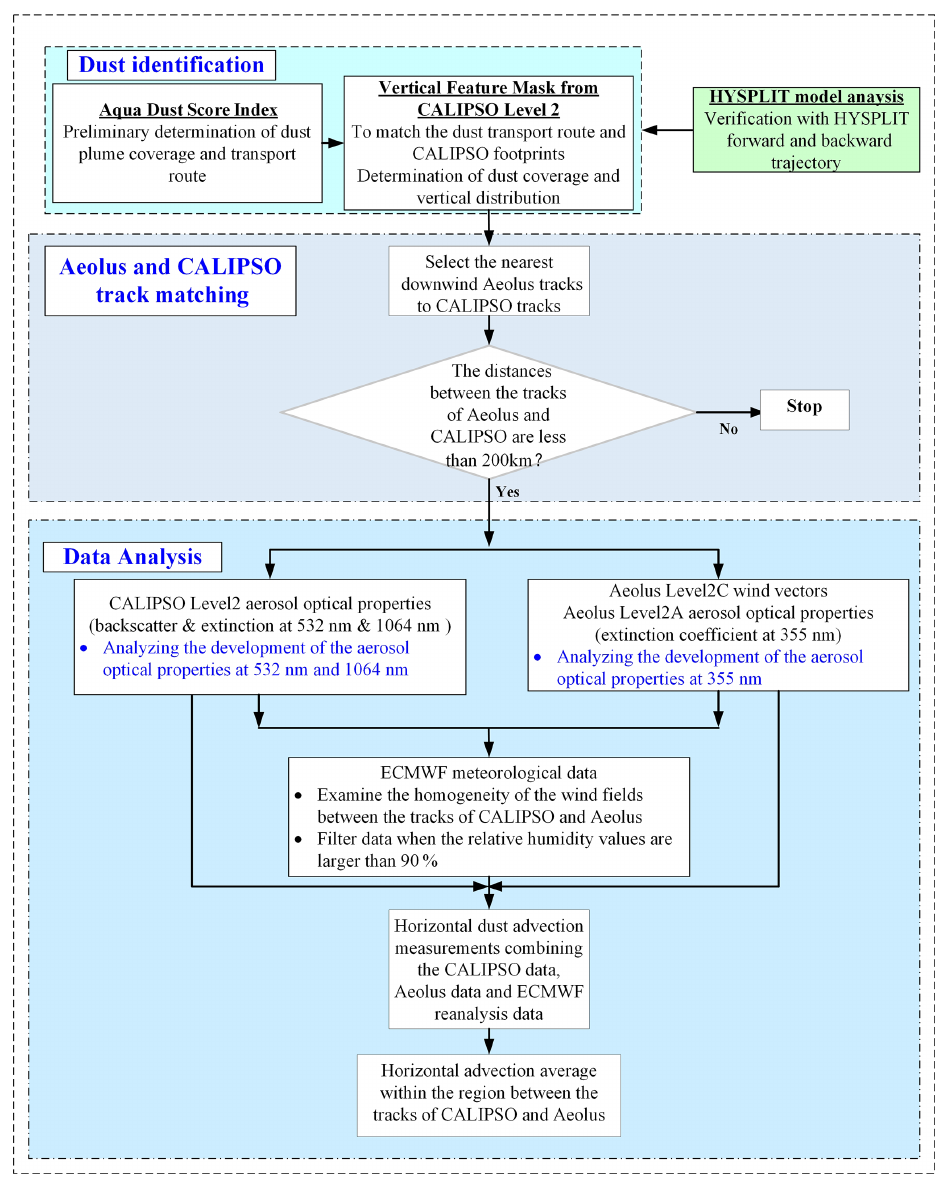
Figure 1. Dust identification, Aeolus and CALIPSO track matching, and data procedures.